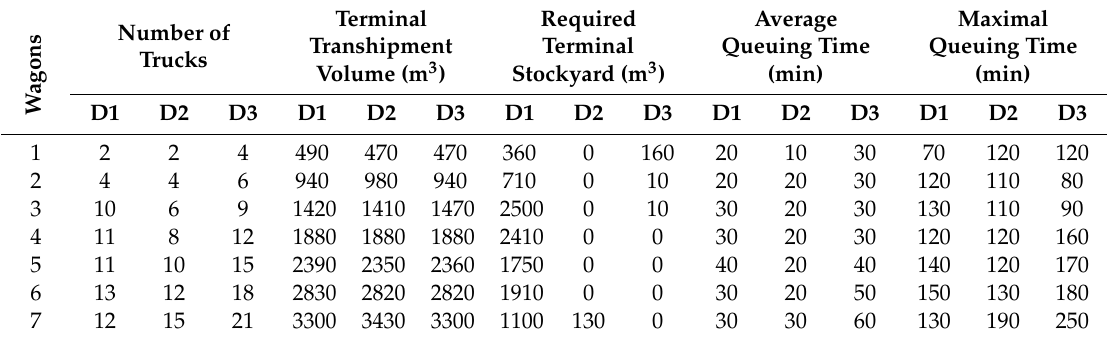
Table8. BestperformingsimulationresultsforstrategyMAXVOLUME(maximalterminaltranshipment volume) for two train pick-ups.